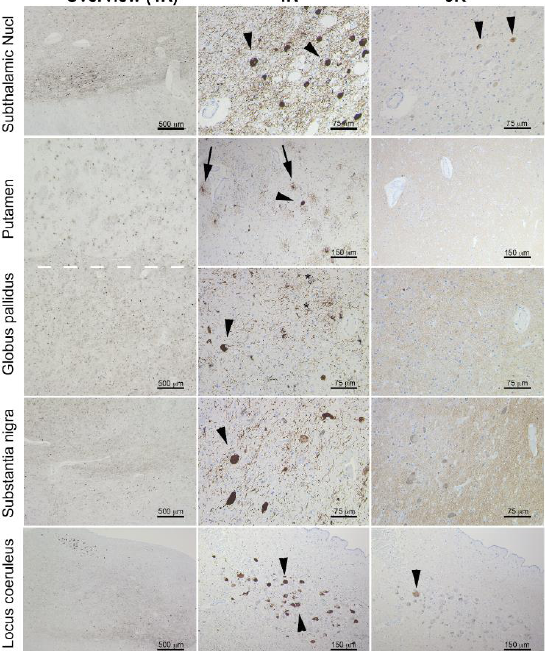
Figure 3. Immunostaining for 4R (left and middle column) and 3R (right column) tau isoforms in the subthalamic nucleus, putamen, globus pallidus, substantia nigra, and locus coeruleus. Note that the pathology is predominated by 4R tau deposition and shows tufted astrocytes (few examples indicated by arrows), globose neurofibrillary tangles (few examples indicated by arrowheads), and coiled bodies (few examples indicated by asterisks). Only a single 3R tau immunoreactive neurofibrillary tangle is seen in the locus coeruleus (arrowhead), and two are seen weakly stained in the subthalamic nucleus